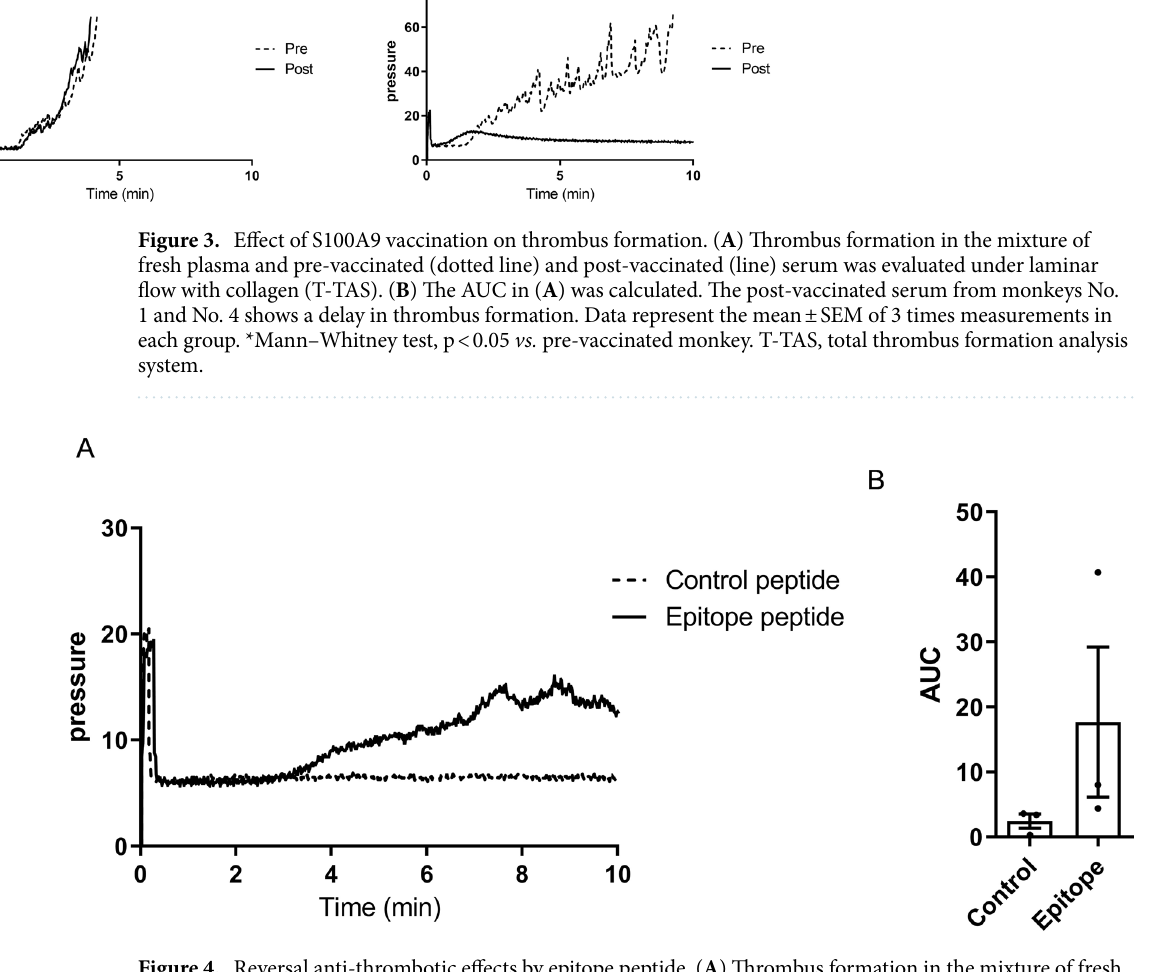
Figure 4. Reversal anti-thrombotic effects by epitope peptide. ( A ) Thrombus formation in the mixture of fresh plasma, post-vaccinated serum from No. 4 monkey, and epitope peptide (line), which could be recognized by the produced antibody. As a negative control, control peptide was added instead of epitope peptide (dotted line). Control peptide had no influences on the anti-thrombotic effects of the peptide vaccine, whereas epitope peptide reversed the anti-thrombotic effect. ( B ) The AUC in ( A ) was calculated. Data represent the mean ± SEM of 3 times measurements. Although there was no significant difference, there was a tendency of increased AUC in the serum mixed with an epitope peptide. Control control peptide, Epitope epitope